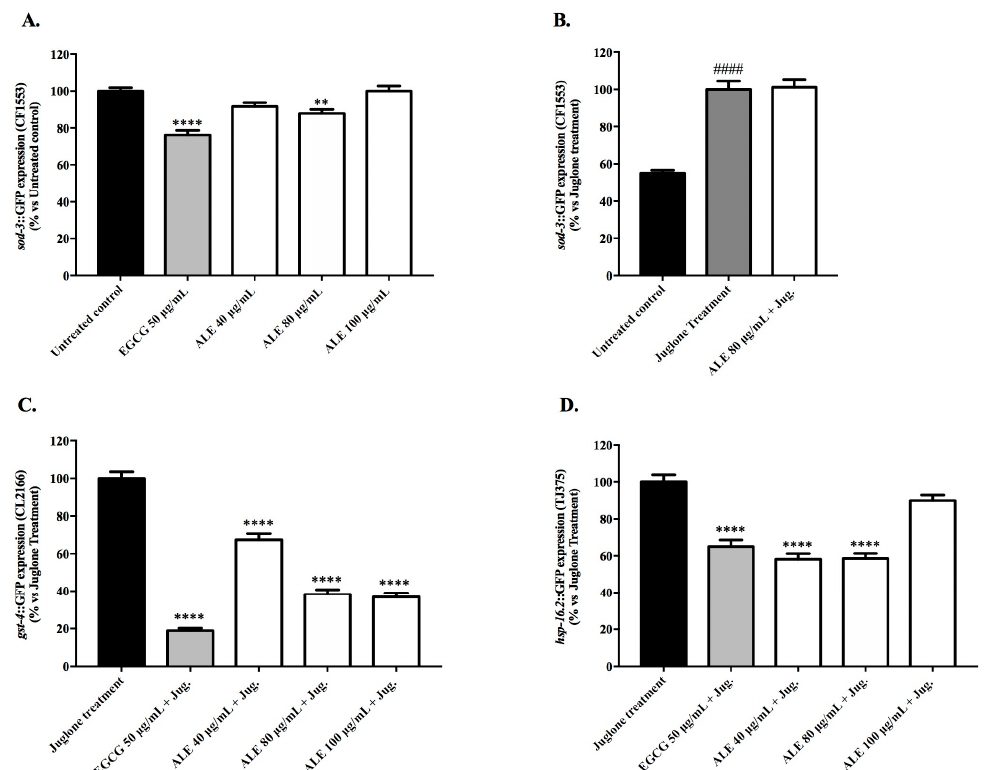
Figure 4. Effect of Uncaria tomentosa leaf extract on the expression levels of stress resistance related genes, showing the following: ( A ) sod-3 ::GFP expression in CF1553 mutant worms under basal stress conditions and ( B ) under juglone-induced oxidative stress; ( C ) gst-4 ::GFP expression in juglone-stressed CL2166 mutant strain and ( D ) hsp16.2 ::GFP expression in juglone-stressed TJ375 mutant worms treated with the ALE extract at 40–100 µ g / mL. . The control groups were the untreated worms, worms pre-treated with EGCG at 50 µ g / mL, juglone-treated worms, and juglone-stressed worms pre-treated with EGCG at 50 µ g / mL. Each bar represents the relative mean ( n = 30) fluorescence intensity ± SEM from three independent assays. The asterisks indicate statistical di ff erences (untreated worms vs juglone-treated worms) according to one-way ANOVA followed by a post-hoc Tukey’s test: ** p < 0.01 and **** p <